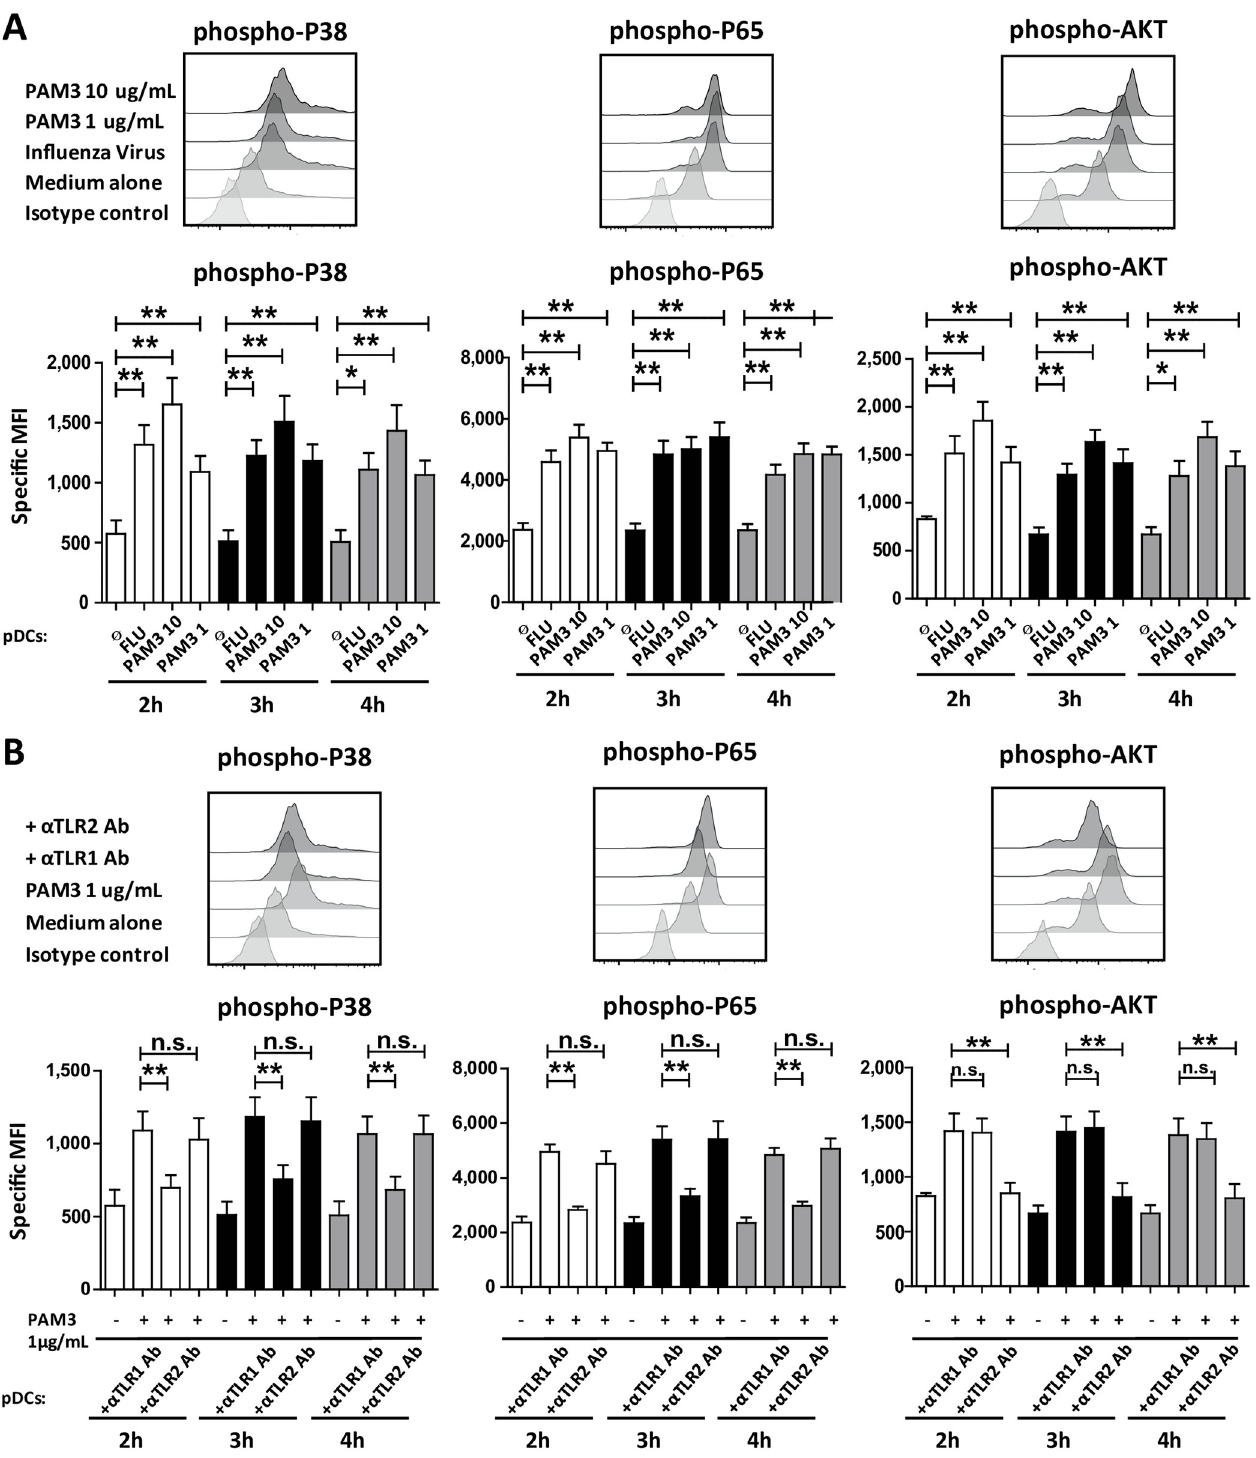
Fig 4. TLR1 and TLR2 exploit distinct pathways following PAM3 stimulation. (A–B) Sorted human blood pDCs were cultured during 4-hours with only medium ( Ø ) and with or without PAM3 in the presence or not of TLR1 neutralizing antibody ( α TLR1 Ab), TLR2 neutralizing antibody ( α TLR2 Ab),